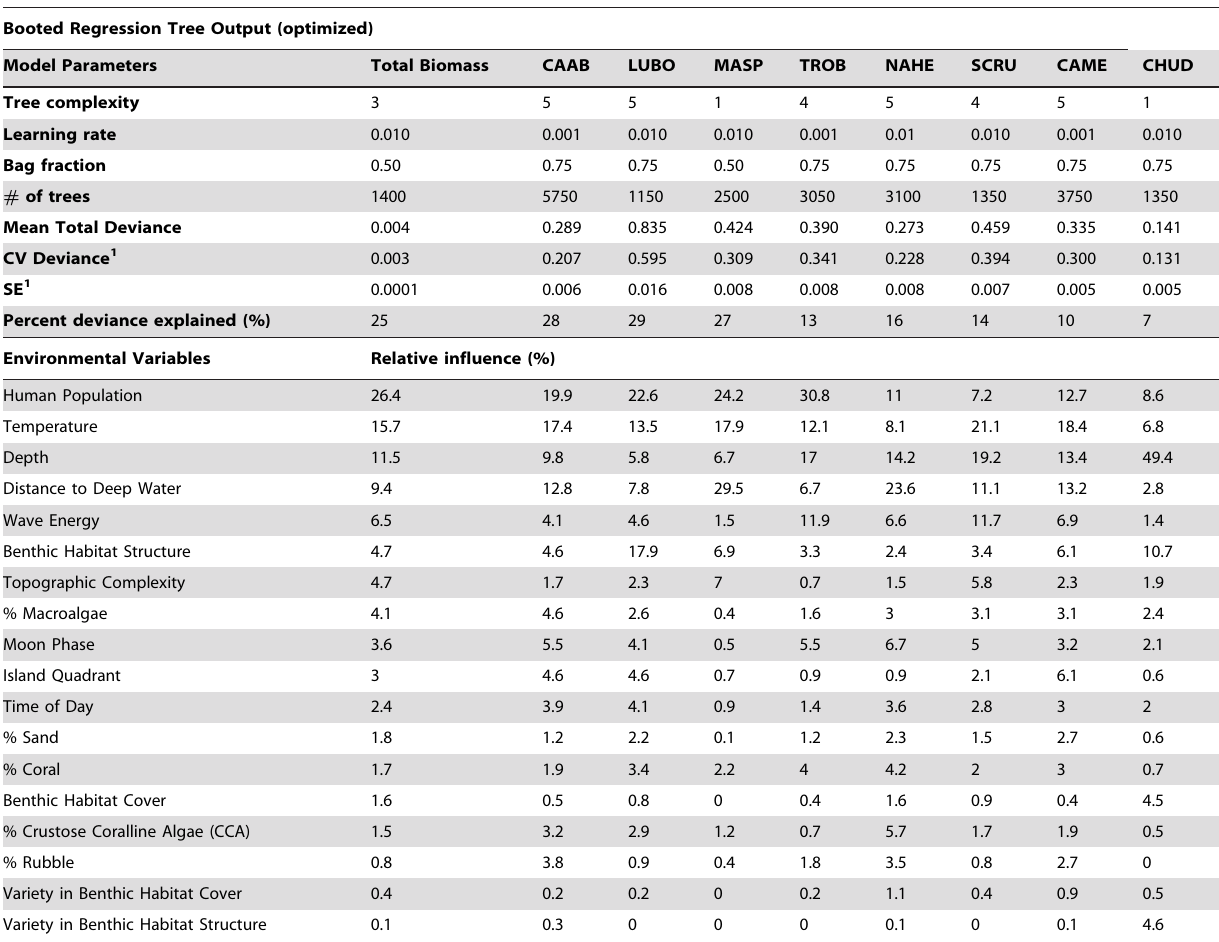
Table 2. Boosted regression tree (BRT) analysis: Optimal parameter settings, predictive performance, and relative influence of environmental variables on total large-bodied reef fish biomass and presence/absence of key species.